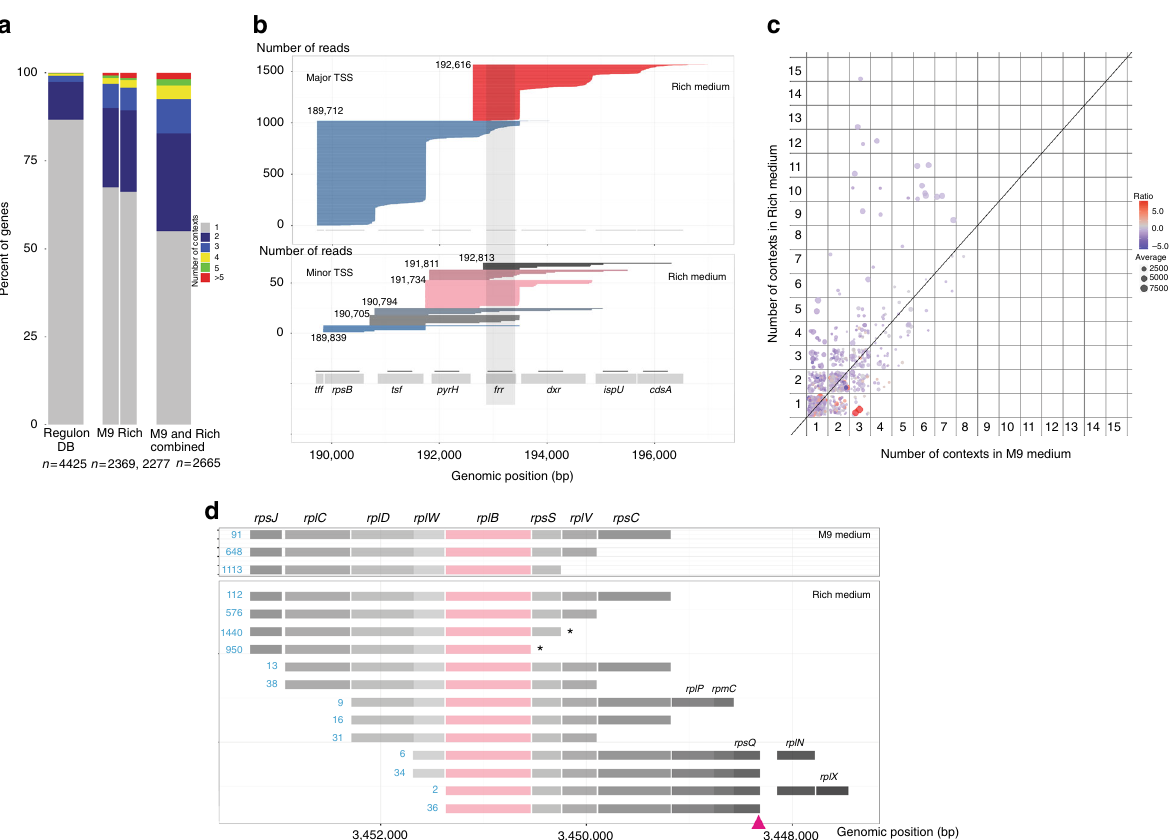
Fig. 3 Transcriptional context. a Distribution of genes according to the number of transcriptional contexts from RegulonDB (left Bar chart), individual SMRT-Cappable-seq (Center Bar charts), and combined SMRT-Cappable-seq data set (Right Bar chart). Only genes having at least one context are considered ( n = the number of genes). The number of transcriptional contexts for a given gene X is the number of unique combinations of genes co- transcribed with gene X. b Individual reads (Rich condition) mapping across the frr gene ordered by TSS location and decreased read size. Read colors represent TSS positions. Reads derived from major and minor TSS are divided into two panels offering different scale for clarity. The frr gene is transcribed from eight different gene contexts when the cells are grown in Rich medium. These contexts are altering the gene content of the transcripts encoding the frr protein. The eight possible combinations are: rpsB-tsf-pyrH-frr , tsf-pyrH-frr-dxr , tsf-pyrH-frr , pyrH-frr-dxr , pyrH-frr , frr-dxr-ispU-cdsA , frr-dxr-ispU , and frr alone. RegulonDB only annotates frr alone. c Number of contexts in M9 medium ( x -axis) compared to the number of contexts in Rich medium for each selected genes. The point size represents the average expression level between the two growth conditions while the color represents the ratio between the expression level in Rich medium compared to M9 medium. d Example of the rplB gene coding for the 50S ribosomal subunit protein L2 showing a change in the number of transcriptional context from 13 contexts (Rich medium) to only three contexts (M9 medium). * indicates the SMRT-Cappable-seq de fi ned TTSs downstream of rpsS and rplB , and red arrow indicates the previously known TTS downstream of rpsQ . The number of reads supporting each context is shown in